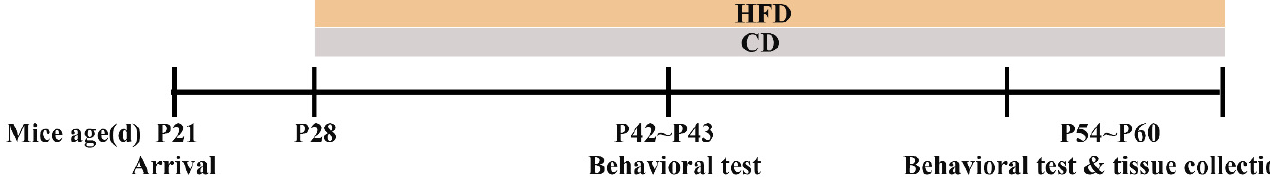
Figure 1. Experimental design showing the age of the animals, duration of dietary treatment, and timing of behavioral testing and tissue collection.